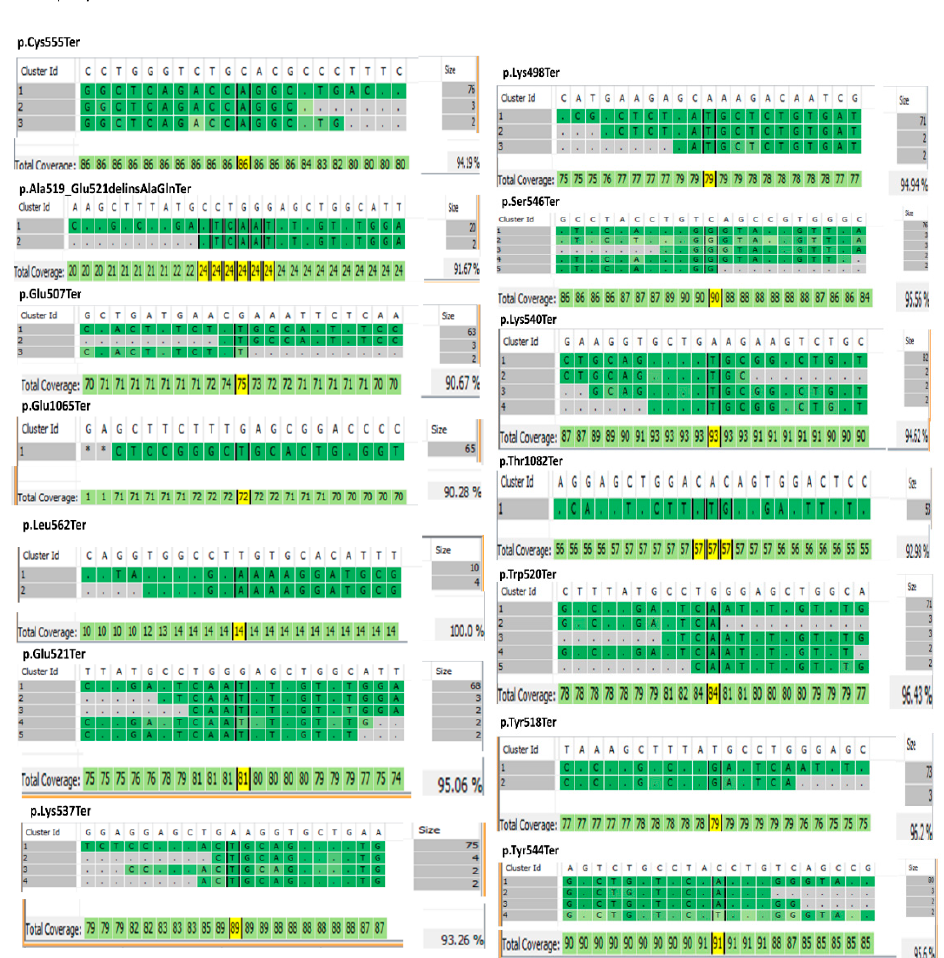
Figure 1. Low-frequency nonsense ABCC1 mutation sequence reads and the corresponding alignments. Reference genome sequence (gray) is on top of each screenshot. Sequence reads from the tumor biopsy with different clusters are labeled in green. Read numbers of each cluster sequence for that region are shown on the right side of each screenshot. On the bottom right side, the coverage percentage for the shown cluster reads is depicted for that region. One patient for each mutation was selected for visualization.